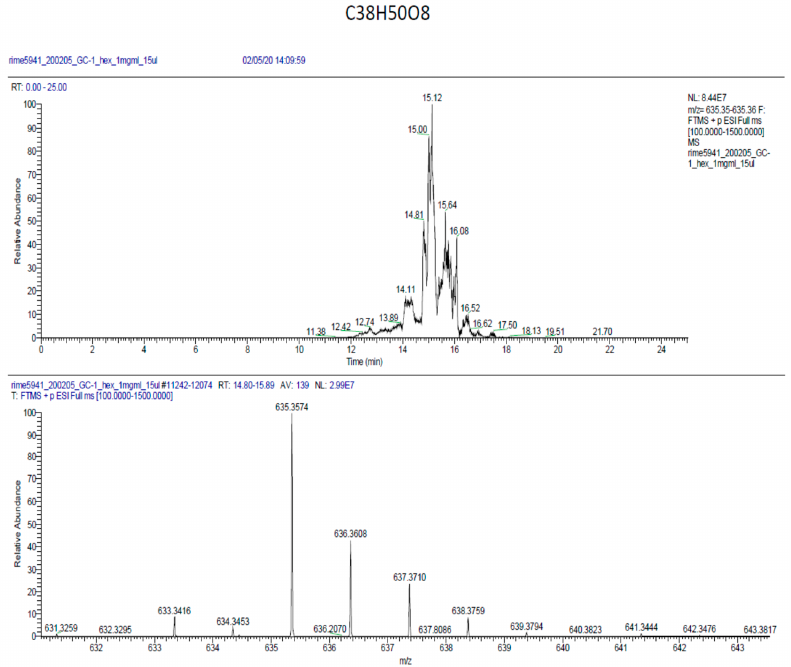
Figure A6. UPLC-MS analysis of the n -hexane extract of G. cambogia indicating the presence of a compound with a molecular formula of C 38 H 50 O 8 .